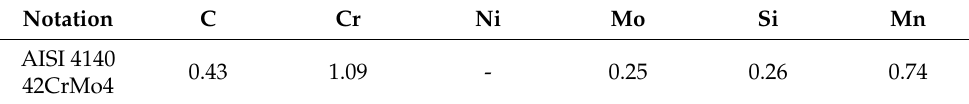
Table 1. Composition of AISI 4140 in weight